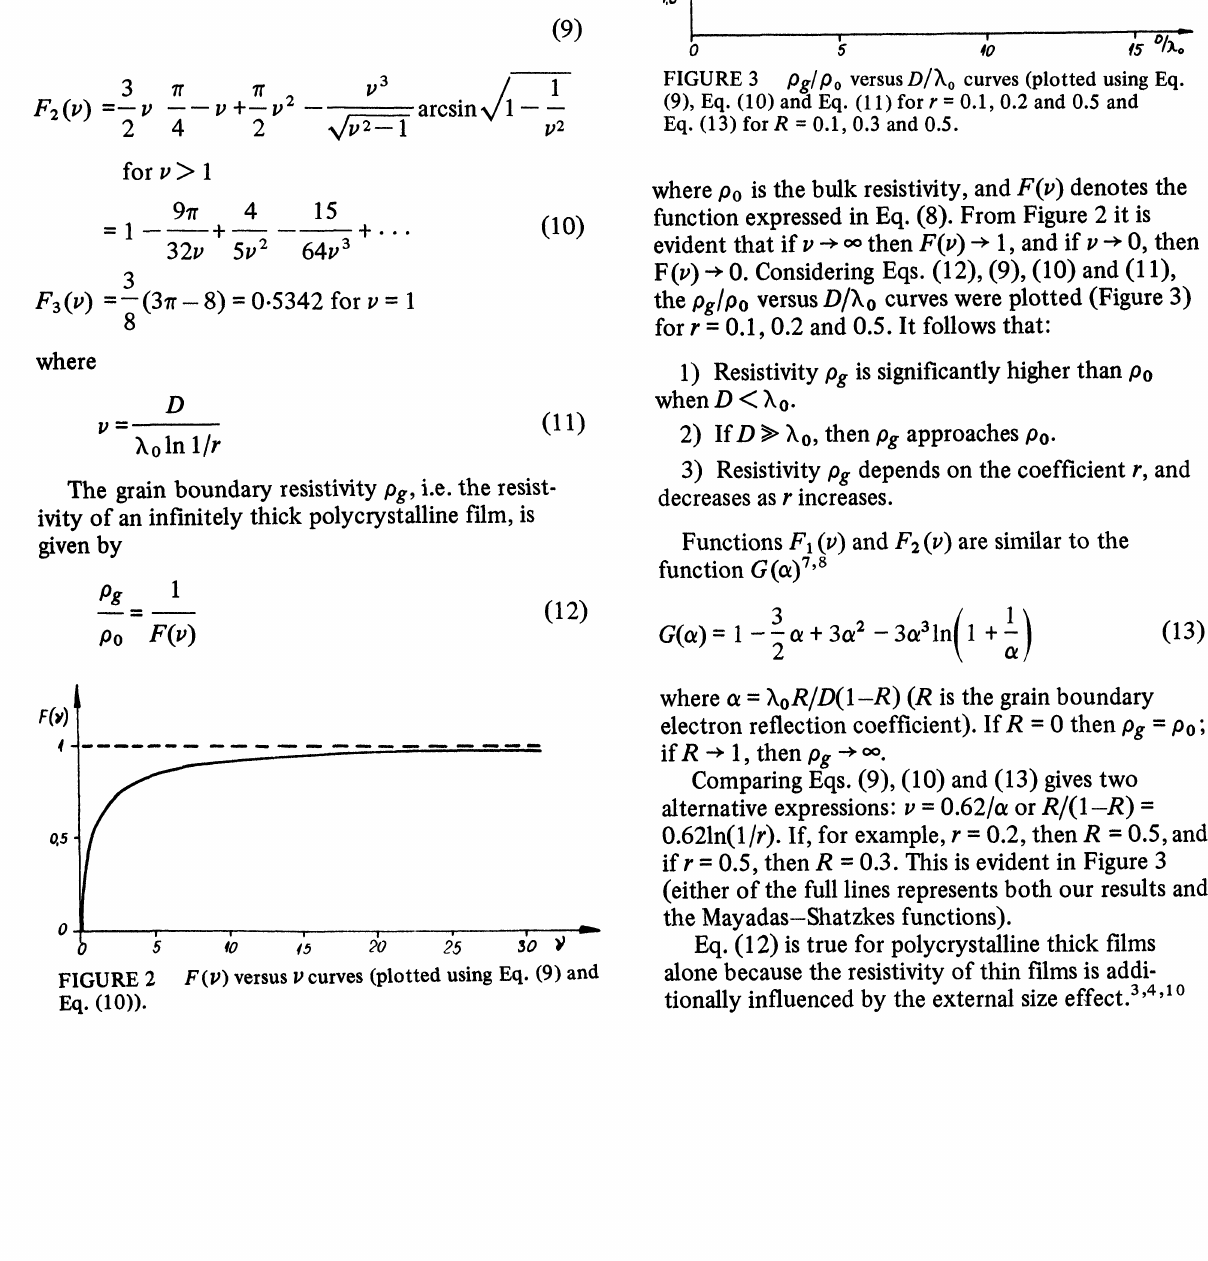
Pg/Po versus D/)ko curves (plotted using Eq. (9), Eq. (10) and Eq. (11) for r 0.1, 0.2 and 0.5 and Eq. (13) for R 0.1, 0.3 and